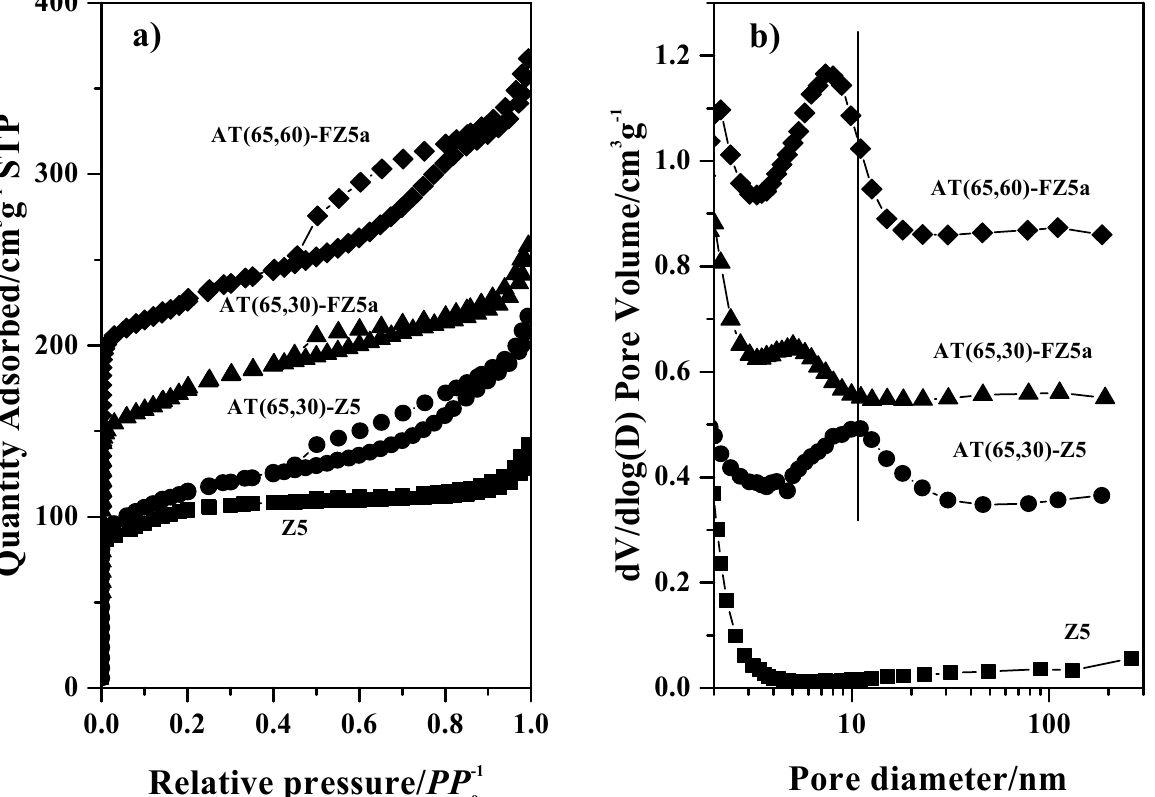
Figure 1. ( a ) N 2 adsorption-desorption isotherms of treated samples. ( b ) BJH pore size distribution derived from the adsorption branches of the isotherms. The isotherms for AT(65,30)-FZ5a and AT(65,60)-FZ5a were offset vertically by 50 and 100 cm 3 g − 1 , respectively. ( b ) Barrett–Joyner–Halenda (BJH) pore size distribution (PSD) data derived from the adsorption branches of the isotherms. The PSD curves of AT(65,30)-Z5, AT(65,30)-FZ5a and AT(65,60)-FZ5a were offset vertically by 0.3, 0.5 and 0.8 cm 3 g − 1 , respectively.